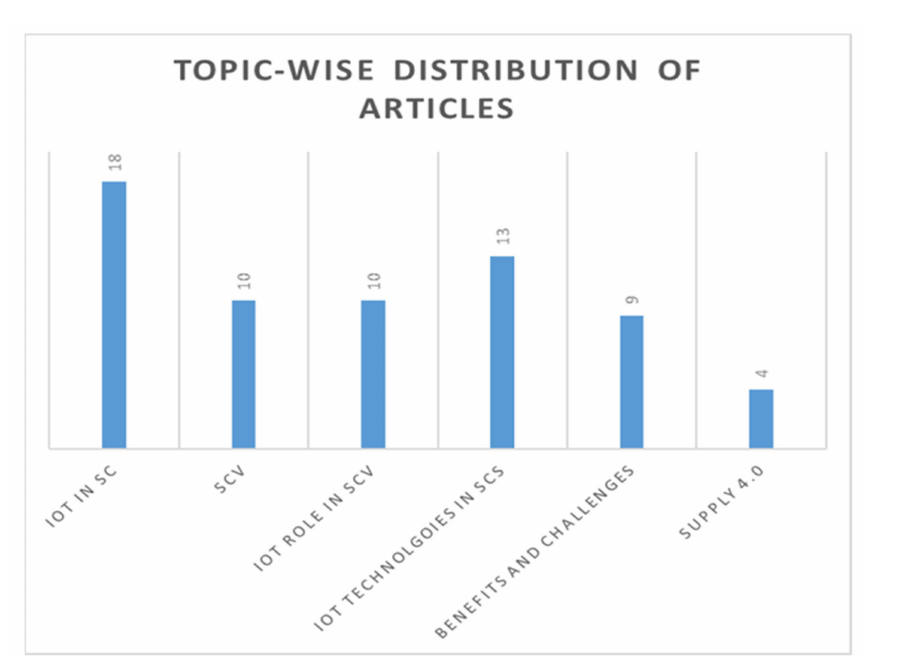
Figure 4. Topic-wise distribution of the